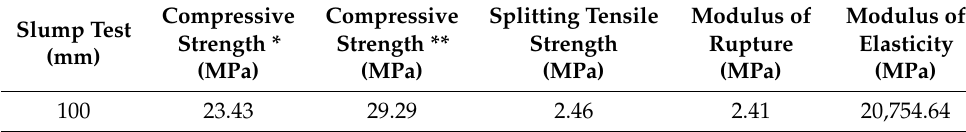
Figure 1. Details of the tested specimens: ( a ) Elevation of the specimens; ( b ) Cross ‐ sections of the tested specimens; ( c ) Geometrical dimensions of the GFRP profile and installment of the shear connectors (Unit: mm). Table 2. Mechanical properties of